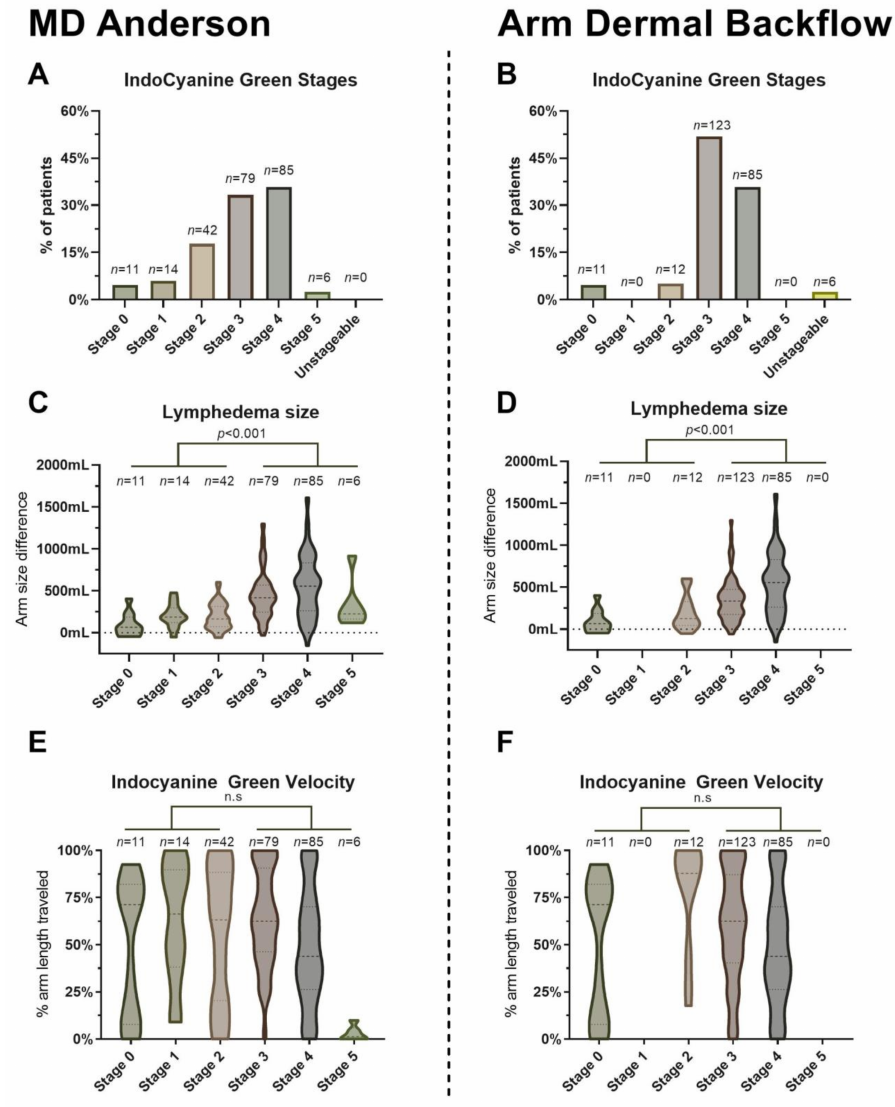
Figure 5. This figure shows the correlation between the MDA and ADB stages and clinical examina- tion. ( A ) This figure shows the distribution of patients by MD Anderson stage. ( B ) This figure shows the distribution of patients by Arm Dermal Backflow stage. ( C ) This figure shows a violin plot of lymphedema volume stratified by MD Anderson stage. The thick dashed line denotes the median, and thin dashed lines denote the interquartile range. Plot thickness denotes the probability density of volumes at different values. ( D ) This figure shows a violin plot of lymphedema volume stratified by Arm Dermal Backflow stages. ( E ) This figure shows a violin plot of ICG velocity stratified by MD Anderson stage. ( F ) This figure shows a violin plot of ICG velocity stratified by the Arm Dermal Backflow stage. n = number of patients, p = p -value, n.s = not significant.